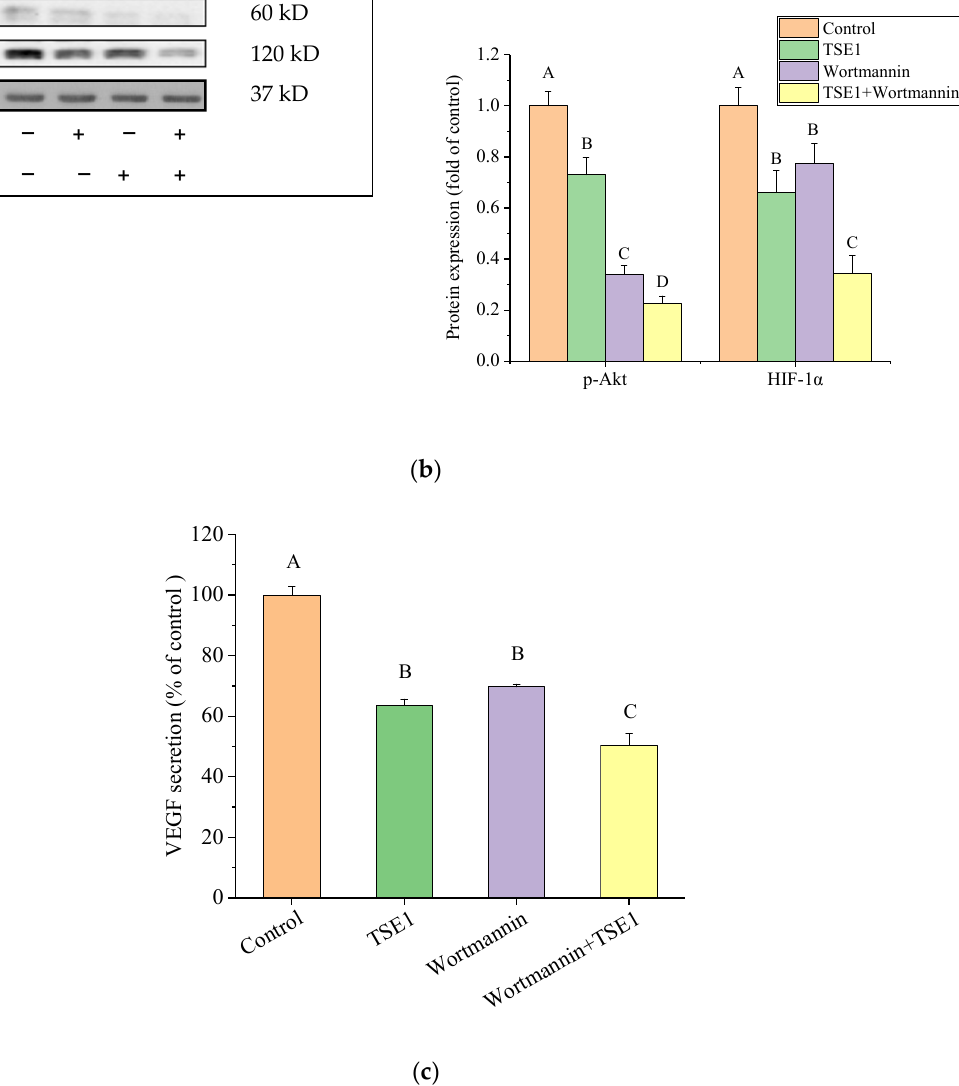
Figure 5. TSE1 regulated the ATM/PTEN/Akt/mTOR/HIF-1 α pathway in OVCAR-3 cells after 24 h treatment. ( a ) Protein expressions of p-ATM, PTEN, p-Akt /Akt, p-mTOR/mTOR, p-p70S6K/p70S6K and p-4E-BP1/4EBP1. ( b ) Combination of TSE1 and wortmannin enhanced the suppressive effect on the protein expressions of p-Akt and HIF-1 α compared with each single compound treatment. ( c ) Combination of TSE1 and wortmannin enhanced the inhibitory effect on VEGF secretion compared with each single compound treatment. Cells were treated with 2 µ M of TSE1, 100 nM of wortmannin or their combination for 24 h. Protein expression was determined by Western blot, and VEGF secretion was determined by ELISA. Results were from three independent experiments and were expressed as means ± SD. Significant differences among different treatments are indicated by different letters ( p < 0.05).